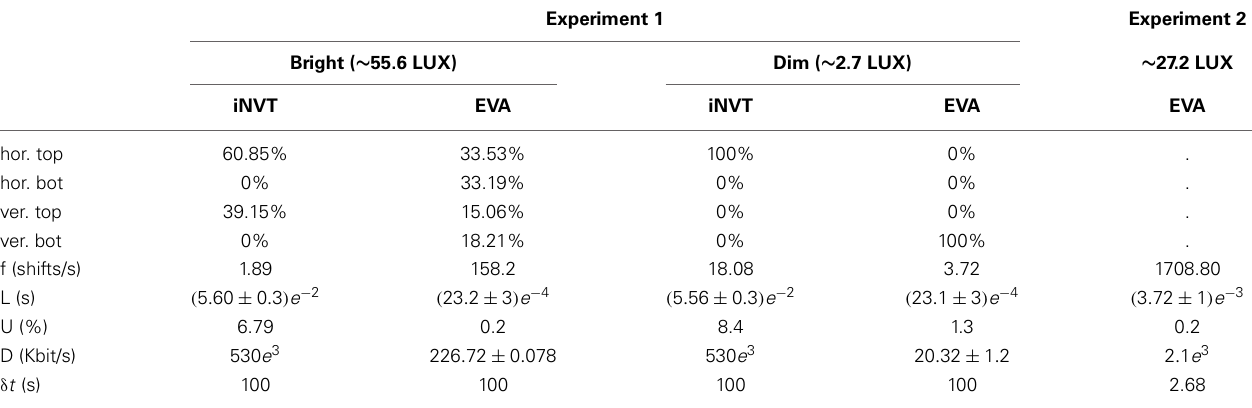
First experiment: number of hits clustered on the horizontally (top and bottom) and vertically (top and bottom) oriented grating stimuli under bright and dim illumination. Second experiment: performance of the EVA in